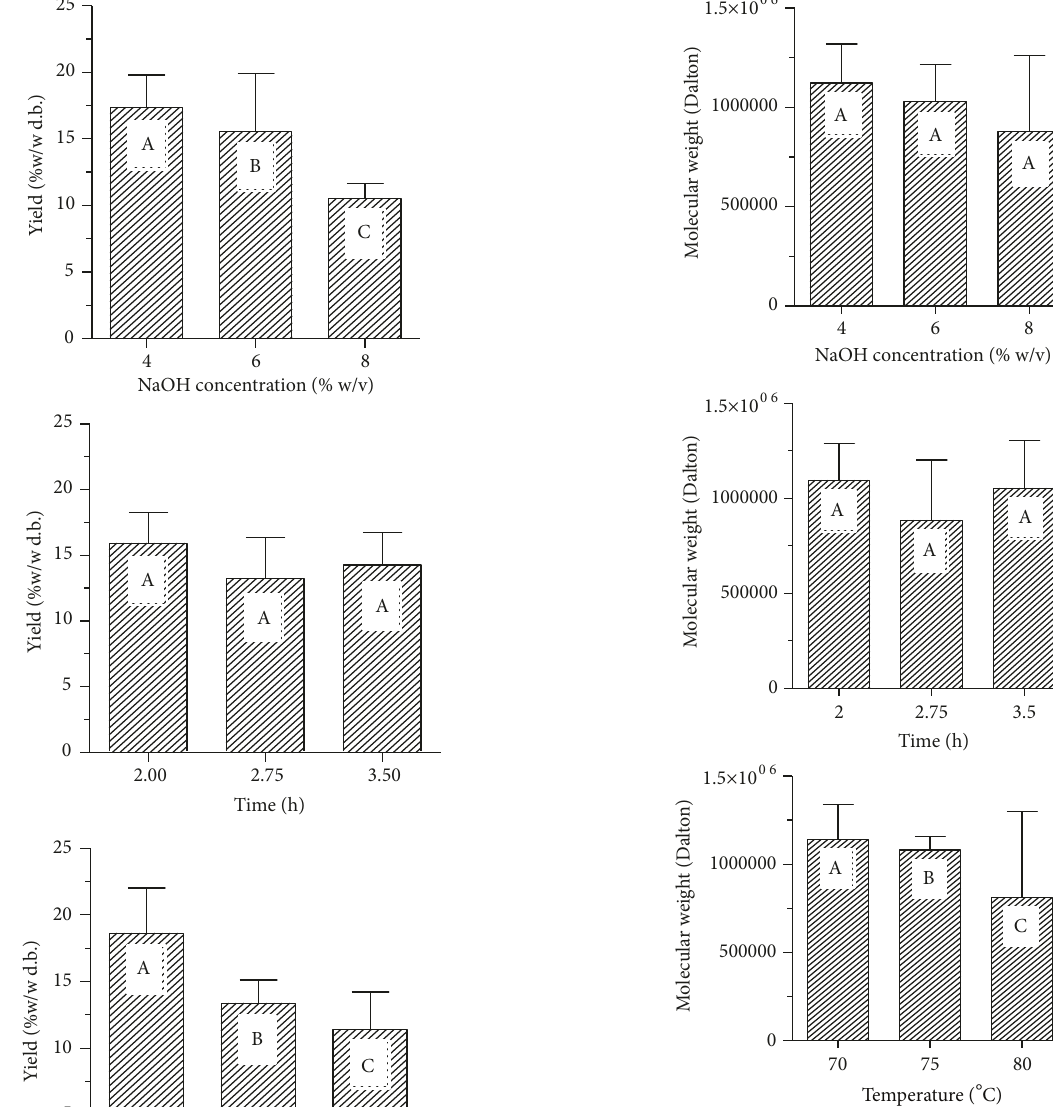
Figure2:EffectsofalkalitreatmentonM W ofcarrageenanextracted from H. bryoides (means with the same letter are not significantly different ( 𝛼 =